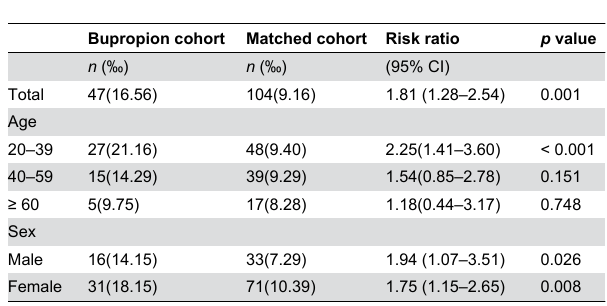
Table 2. Incidence of urticaria occurrence in depressive patients